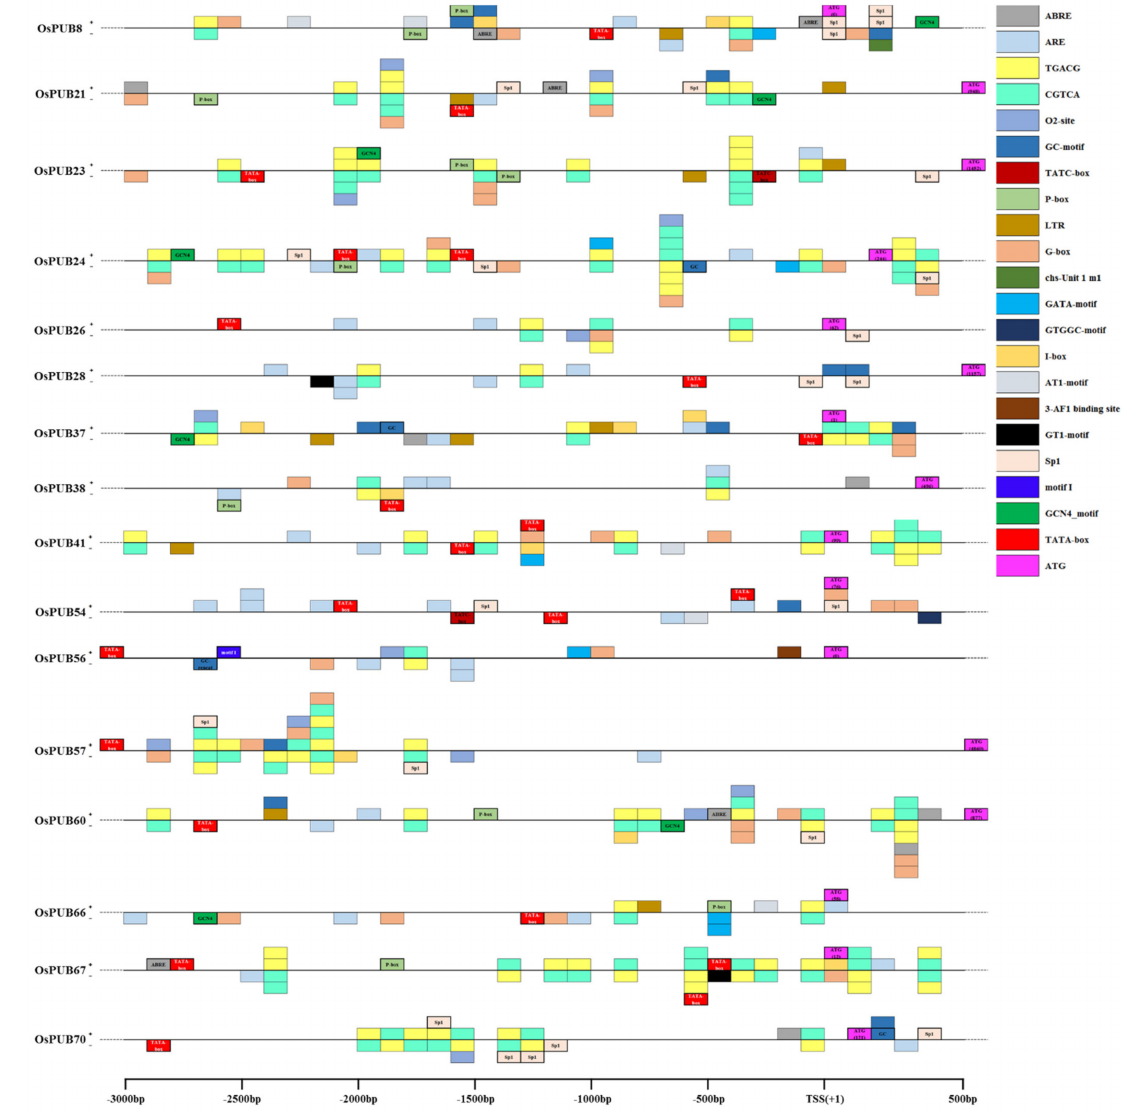
Figure 7. Distribution of stress-related cis-acting elements in promoter sequences of 16 OsPUB genes. Cis-elements distributed on the sense strand and the reverse strand are indicated above and below black lines, respectively. The 3 kb sequences upstream of the Transcription Start Site (TSS) of OsPUB genes can be estimated using the scale per 500 bp at the above. 3-AF1 binding site: light responsive element; ABRE: cis-acting element involved in the abscisic acid responsiveness; ARE: cis-acting regulatory element essential for the anaerobic induction; AT1-motif: part of a light responsive module; CGTCA-motif: cis-acting regulatory element involved in the MeJA-responsiveness; chu-Unit 1 m1: part of a light responsive element; GATA-motif: part of a light responsive element; G-box: cis-acting regulatory element involved in light responsiveness; GC-motif: enhancer-like element involved in anoxic specific inducibility; GT1-motif: light responsive element; I-box: part of a light responsive element; LTR: cis-acting element involved in low-temperature responsiveness; O2-site: cis-acting regulatory element involved in zein metabolism regulation; P-box: gibberellin-responsive element; Sp1: light responsive element; TATA-box: core promoter element around − 30 of transcription start; TATC-box: core promoter element around − 30 of transcription start; TGACG-motif: cis-acting regulatory element involved in MeJA-responsiveness. The cis-acting regulatory elements of Oryza sativa are indicated by a bold border and written inside a box. Cis-elements for other crops ( Zea mays , Hordeum vulgare , Triticum aestivum , and Solanum tuberosum ) are displayed only with thin borders. * The regions having several boxes (such as 1800 bp of OsPUB21) are with several cis-elements in a 100 bp interval. The closest box on the line means near to the starting bp of each multiple-box